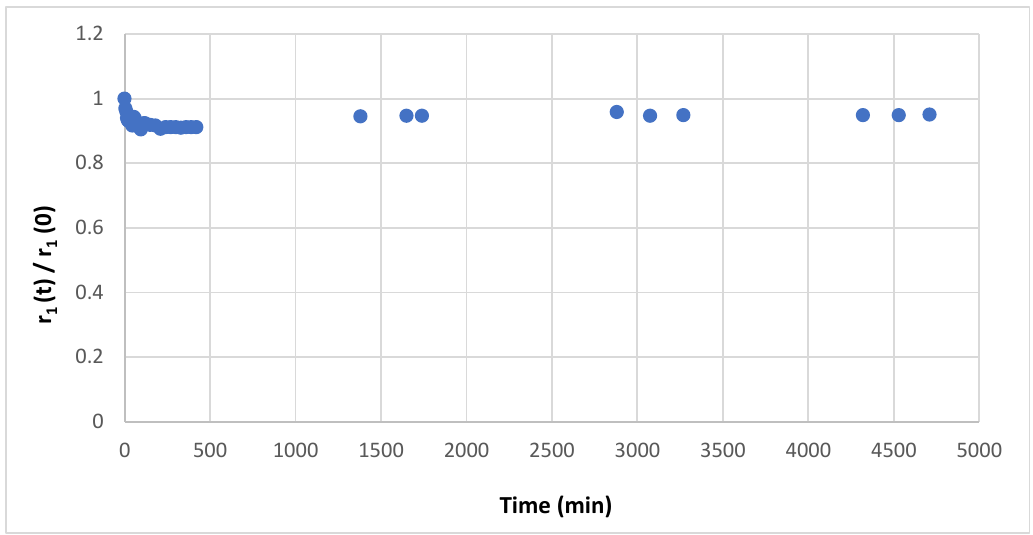
Figure 5. Evolution of R 1p (t)/R 1p (t = 0) vs. time for the complex 7 a in the presence of Zn 2+ ions in phosphate buffer solution.